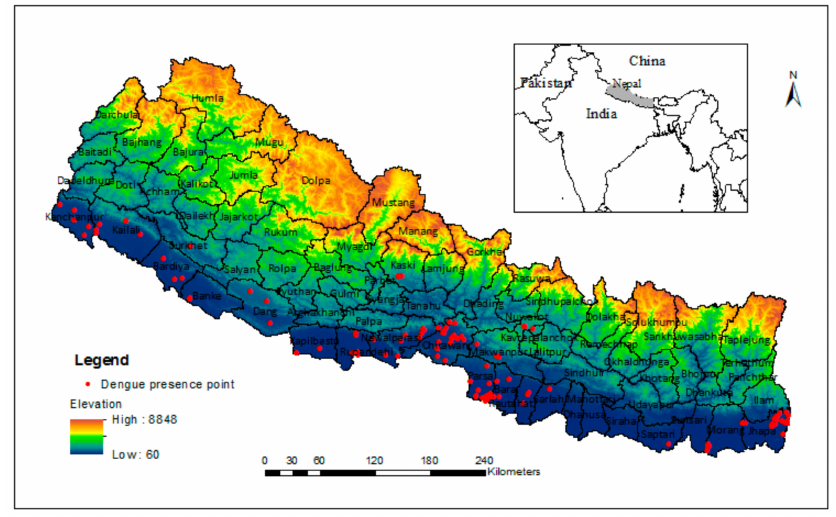
Figure 1. Study area showing elevation gradient and location of reported dengue cases in